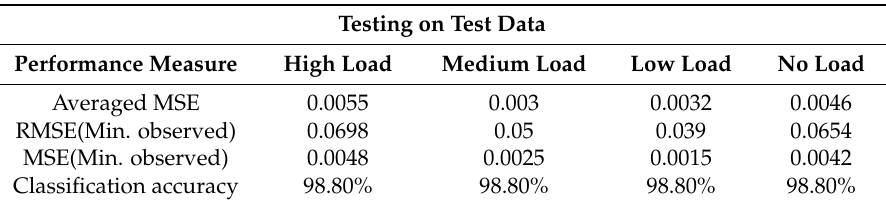
Table 8. Performance of MLP ‐ NN ‐ based classifier on test data.